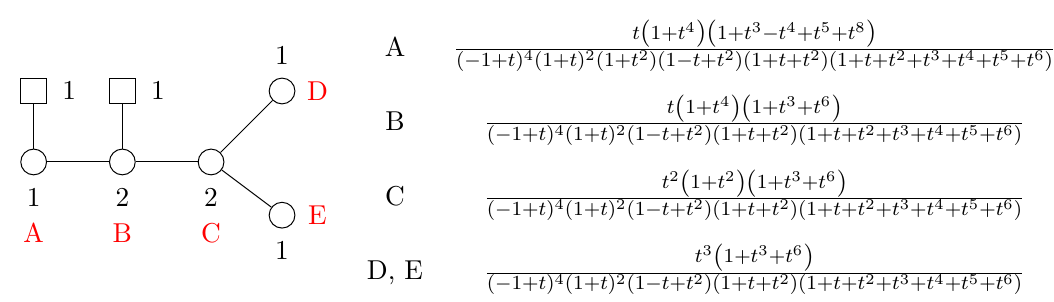
Table 13. E 3 family for k = 2 . B-twisted index with Wilson lines at the labelled position in the